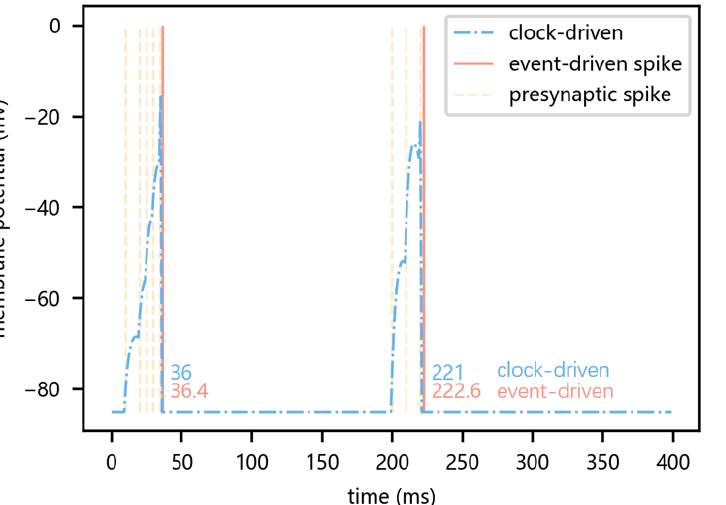
Figure 4. Event-driven model and clock-driven model spikes example. Numbers at the bottom of the figures are exact spike time of clock-driven and event-driven models with corresponding colors,